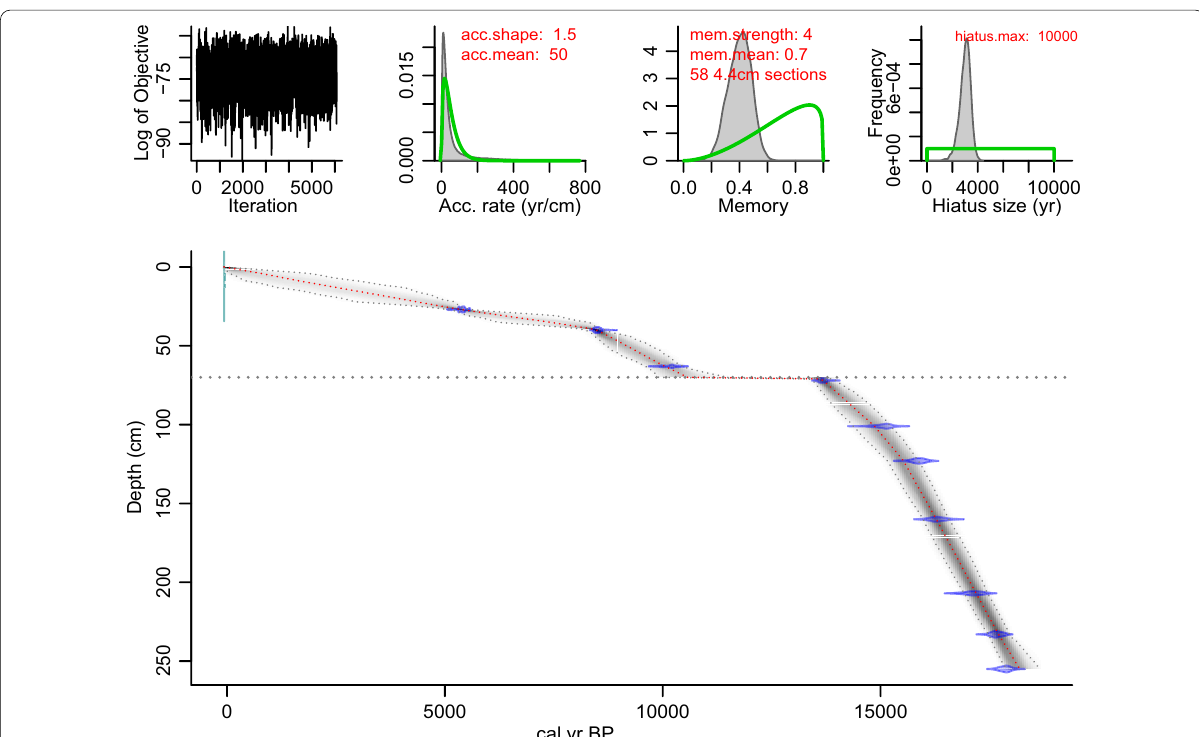
Fig. 3 Bayesian age‑depth model for profile B4 according to Blaauw and Christen (2011). Top left: The log‑likelihood of the model fit for the saved iterations of the model, top middle: prior and posterior distribution of accumulation rate, and top right: prior and posterior distribution of the autocorrelation in accumulation rates (memory) and the time gap (hiatus size) at the end. Bottom panel shows the calibrated 14 C dates (transparent blue) and the age‑depth model (darker greys) indicate more likely calendar ages; grey stippled lines show 95% confidence intervals; red curve shows single ‘best’ model based on the mean age for each